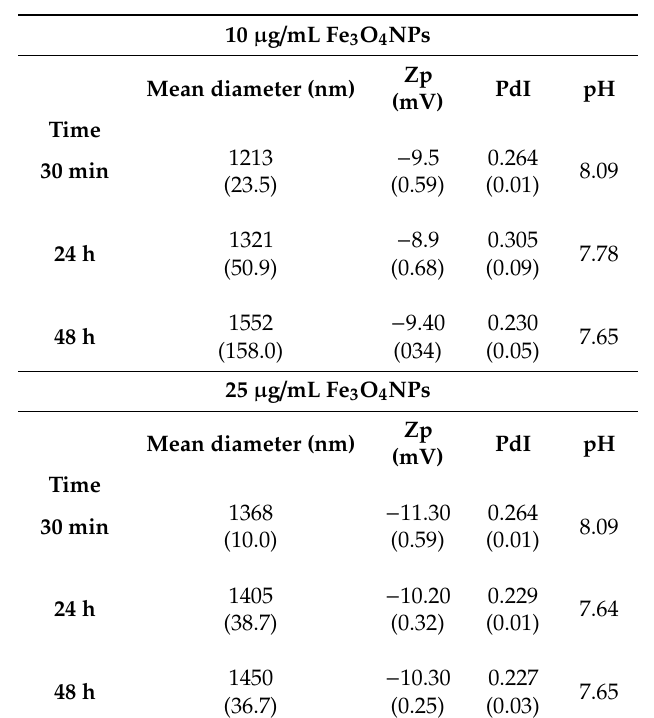
Table 2. Physico-chemical properties of Fe 3 O 4 NPs suspension in neurogenic